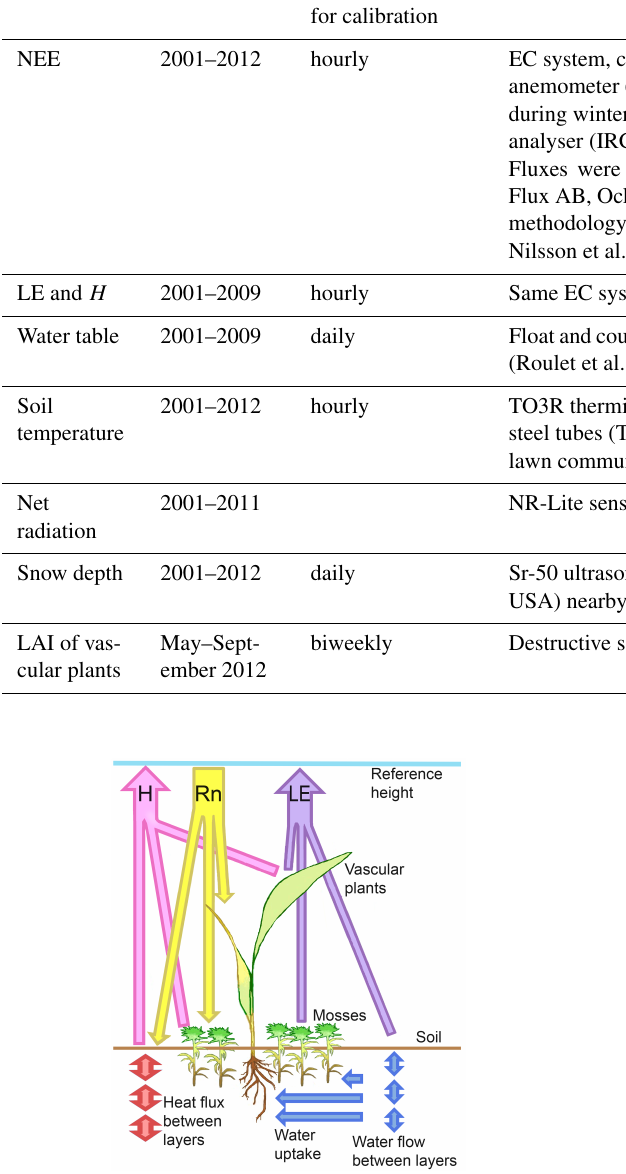
Figure 1. Energy flux partitioning and related soil water flows in the CoupModel as applied to a peatland using two plant canopies and root systems. Rn: Incoming radiation; LE: latent heat fluxes (sum of actual transpiration, interception evaporation and soil evaporation); H : sensible heat